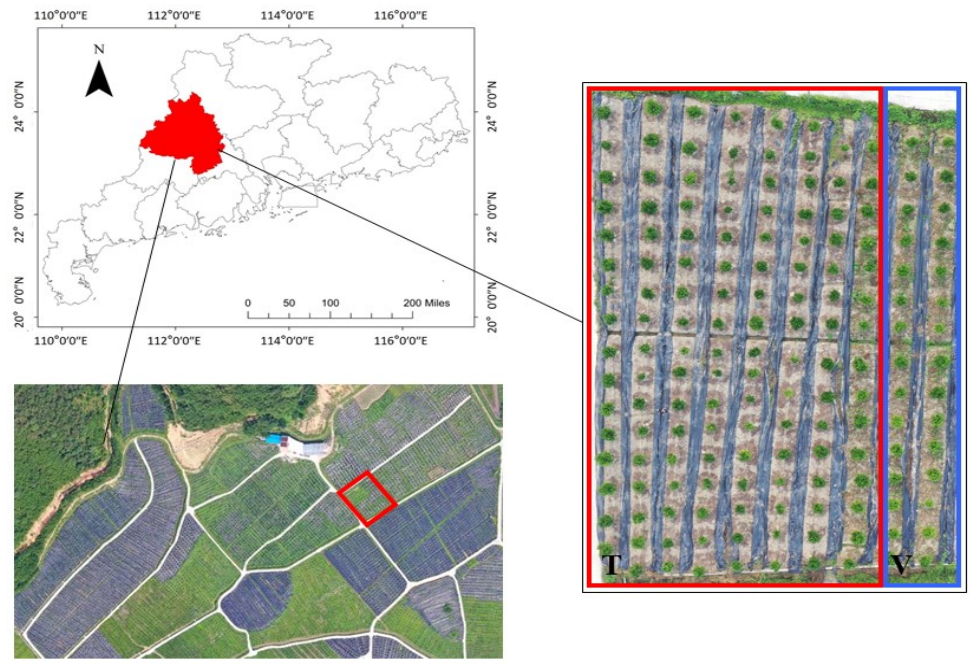
Figure 1. Experimental